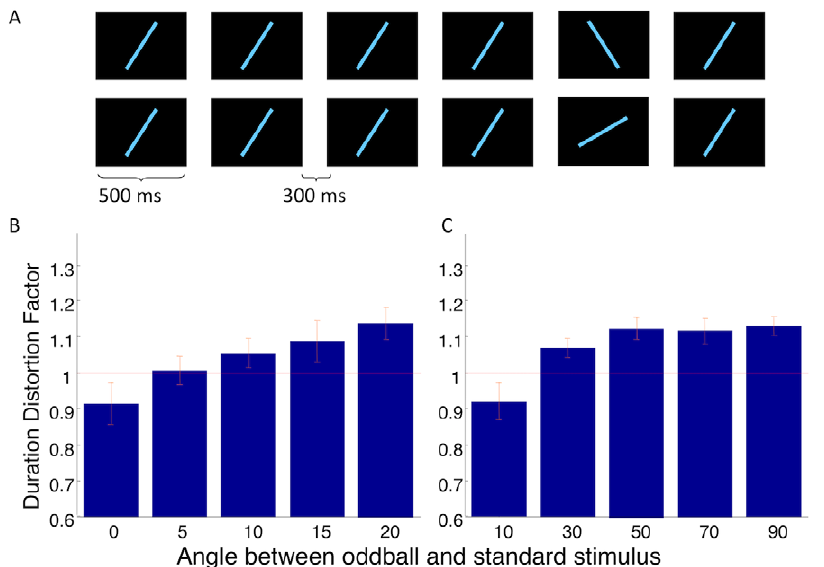
Figure 2. The size of the oddball effect depends on the degree of novelty between the oddball and the repeated stimulus. (A) Cartoon depicting two possible trials. Top: the oddball is very different compared to the standard; bottom: oddball is very similar to the standard. (B) The size of the oddball effect increases linearly with the difference in angle between the oddball and standard stimuli. (C) The effect of novelty saturates by , 50 u of difference.